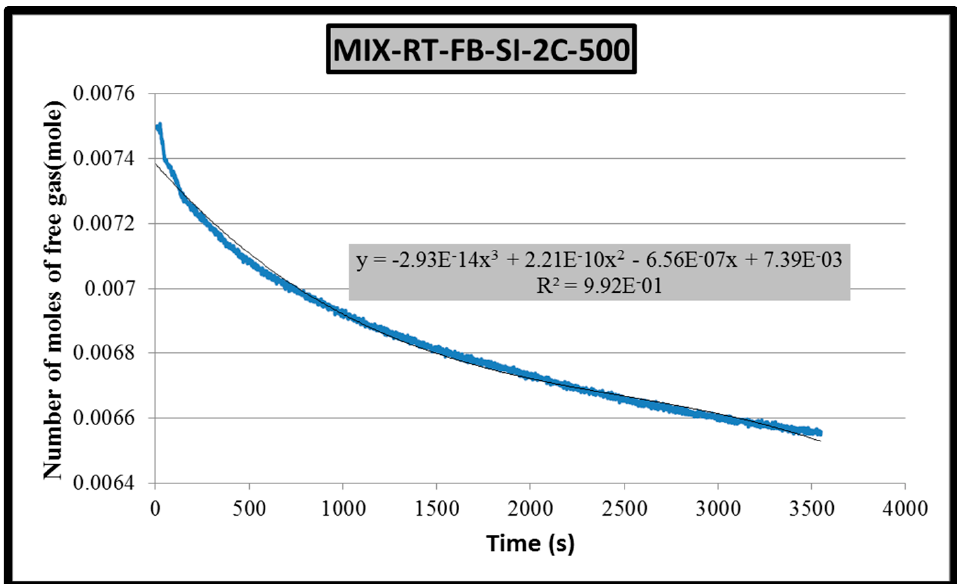
Figure 5. Gas consumption rate equation (2 °C).